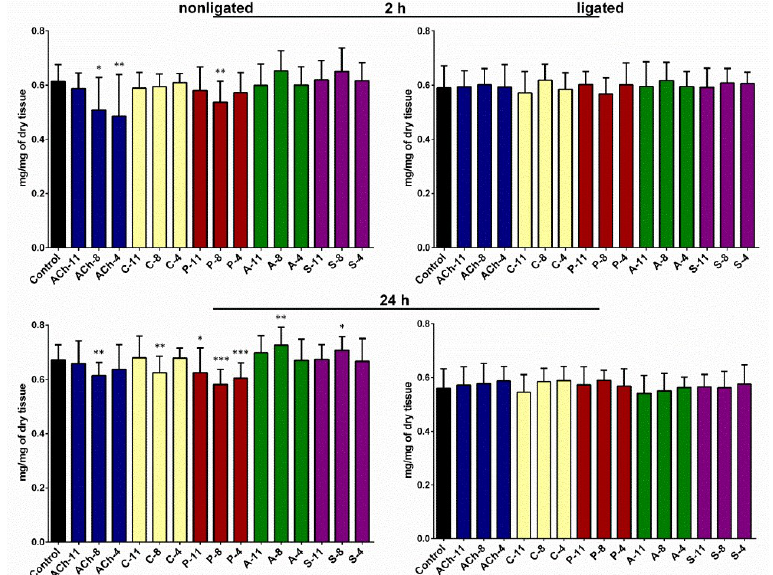
Figure 4. Total lipid content in the fat body of nonligated and neck-ligated larvae of T. molitor beetles injected with acetylcholine (ACh), carbachol (C), pilocarpine (P), atropine (A), and scopolamine (S) at concentrations of 10 − 11 (X-11), 10 − 8 (X-8), and 10 − 4 (X-4) M, respectively, for each compound. The samples were collected after 2 and 24 h of incubation. The control larvae were treated with saline. Mean ± SD are given from at least 15 determinations. Statistically significant differences from the control values are indicated by asterisks (Student’s t -test), where * p ≤ 0.05, ** p ≤ 0.01, and *** p ≤ 0.001.